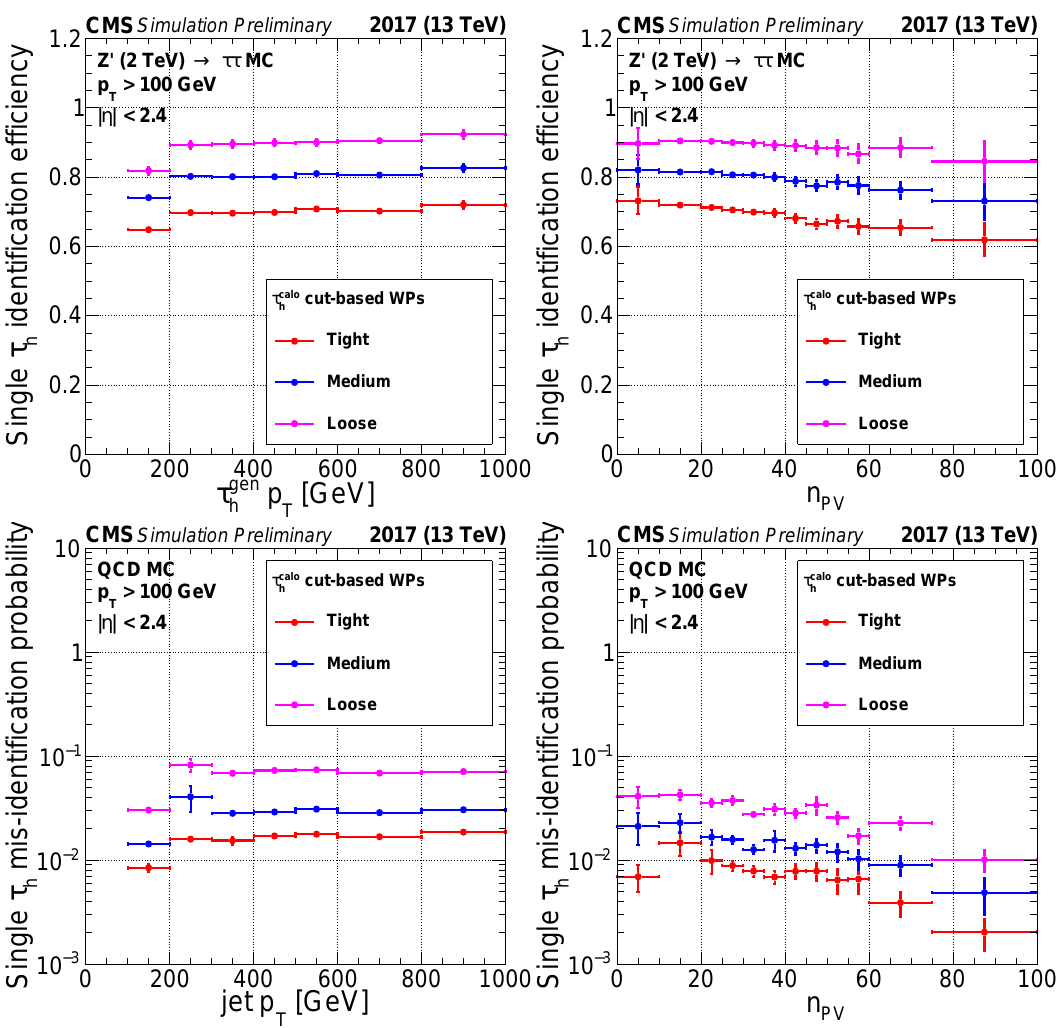
Figure 4: Left: Efficiencies (top) and misidentification probabilities (bottom) of the different isolation-based calo-tau working points as a function of generated τ (in Z (cid:48) ( 2 TeV ) → ττ events) and jet p left, but as a function of the number of